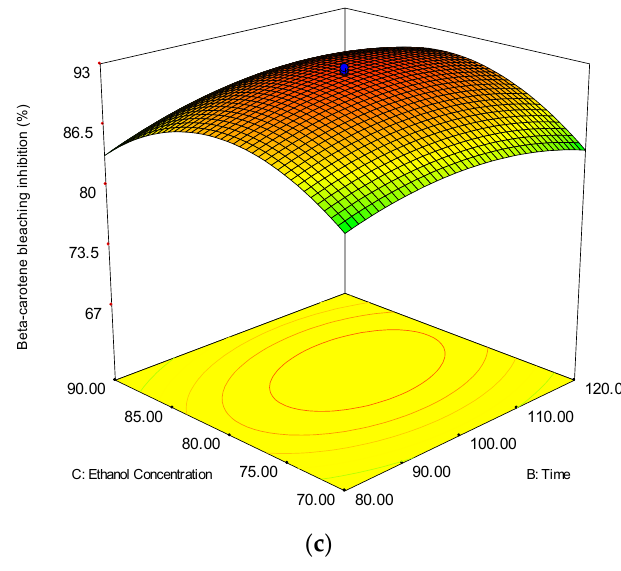
Figure 3. The response surface (3D) and contour plots showing the effect of extraction temperature and time ( a ); temperature and ethanol concentration ( b ) extraction time and ethanol concentration ( c ) on the β -carotene bleaching inhibition of the red pitaya peels.